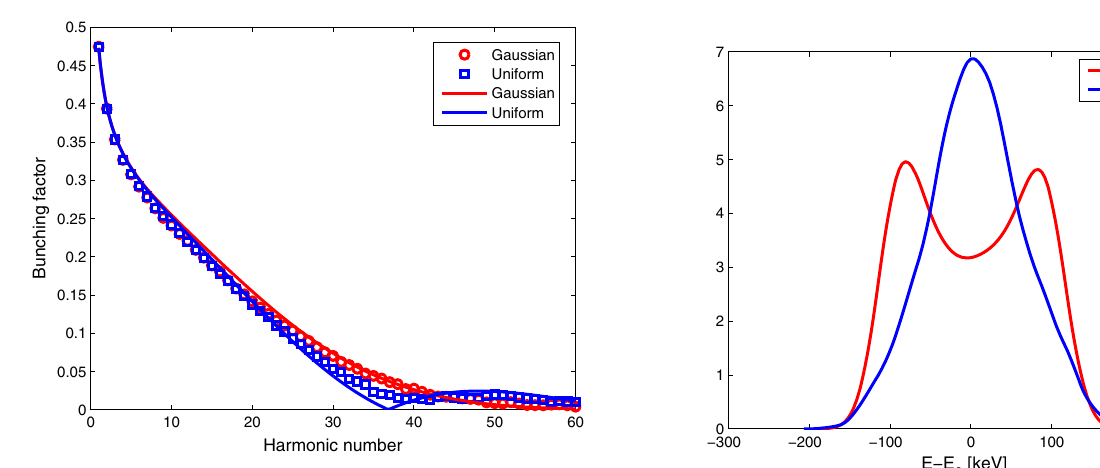
FIG. 6. The saddle and Gaussian sliced beam energy distribu- tion at the exit of the